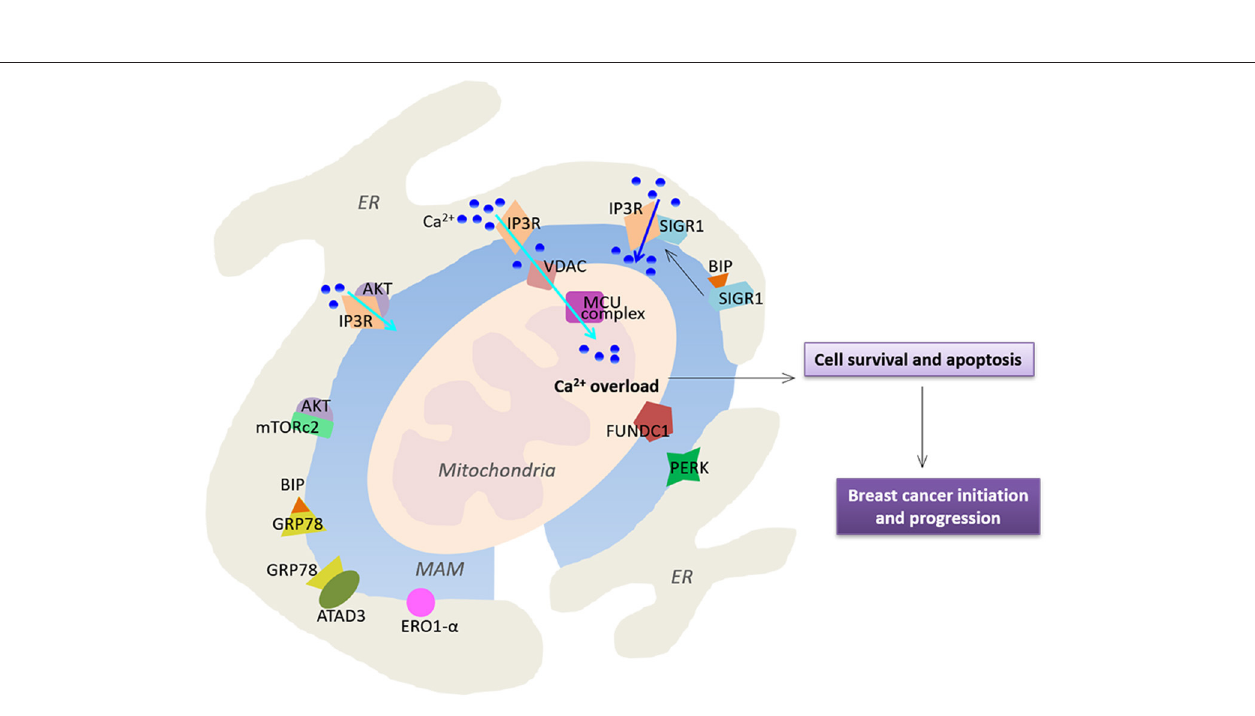
Frontiers in Cell and Developmental Biology |